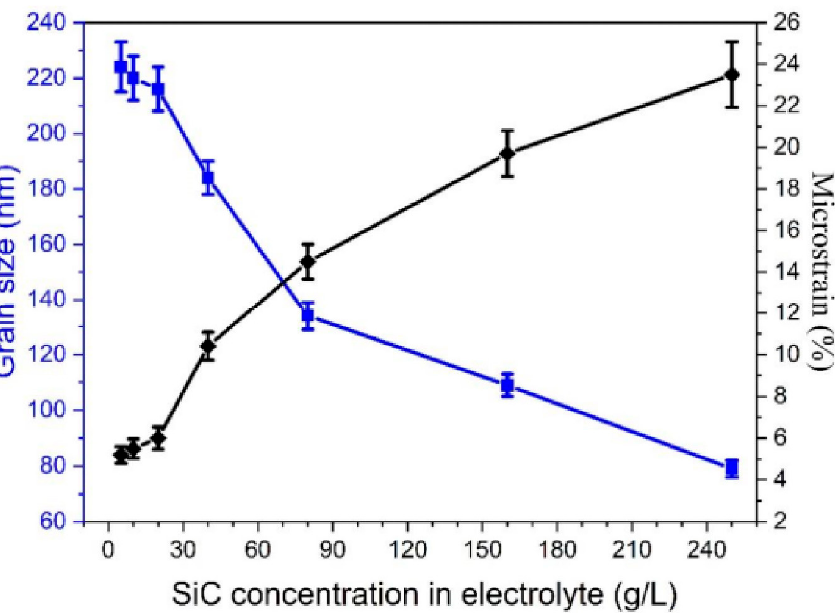
Figure 2. Grain size and microstrain distribution of Ni matrix with various concentrations of SiC particle concentrations.